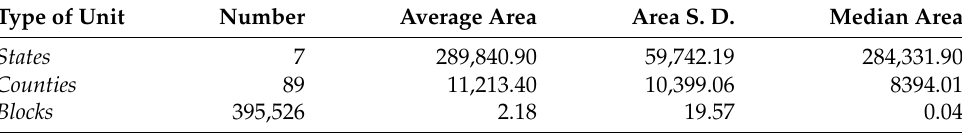
Figure 1. U.S. Census blocks in the Colorado river basin. The 395,526 U.S. Census blocks (represented in red) intersecting CRB (represented in black—U.S. Census 2010 boundaries [38]). Table 1. Summary statistics for main U.S. Census units intersecting the CRB (areas in km 2